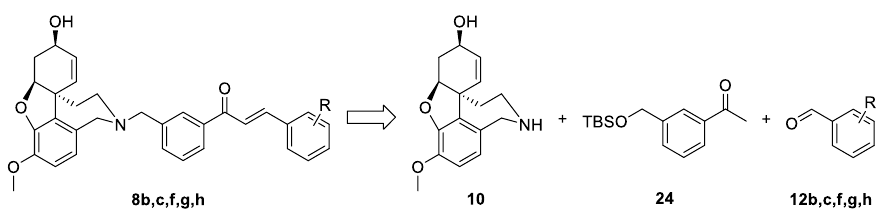
Figure 6. Retrosynthetic analysis of compounds 8b , c , f , g , h .